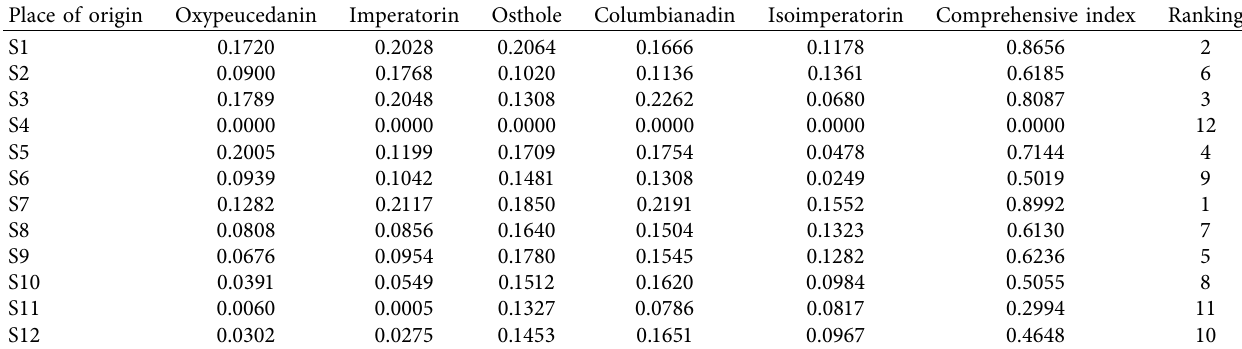
Table 5: Membership values and composite index rankings of APR in different